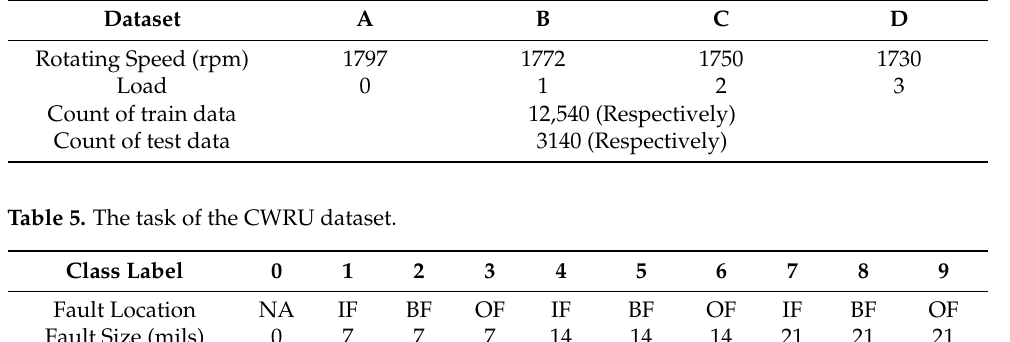
Table 5. The task of the CWRU dataset.